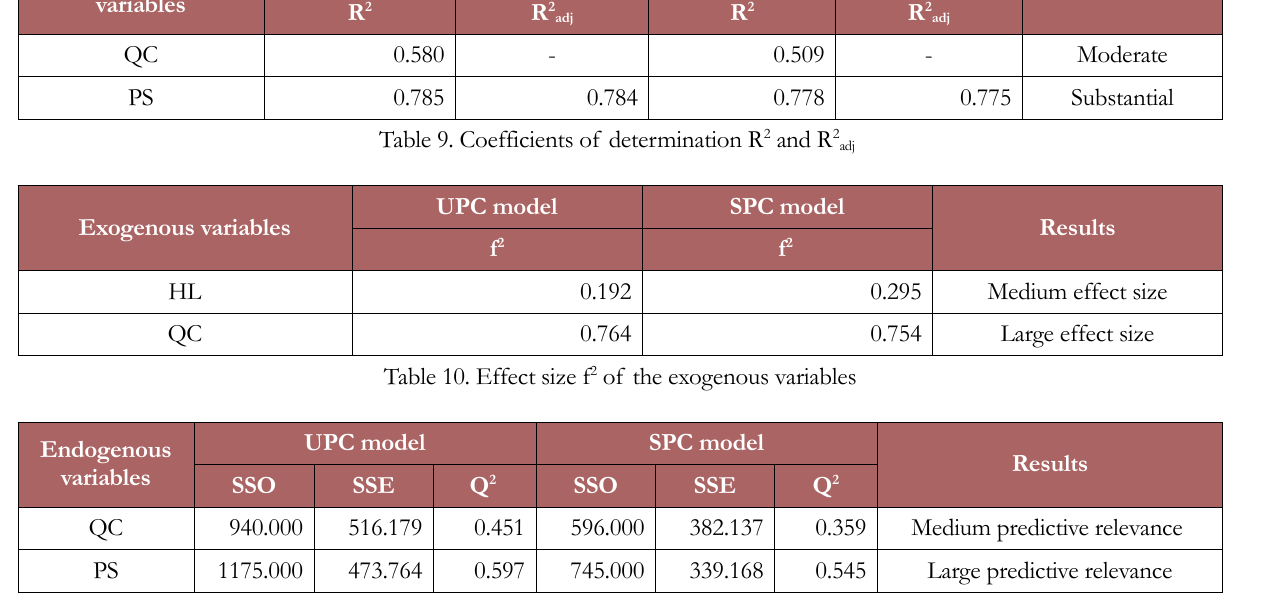
Table 11. Blindfolding